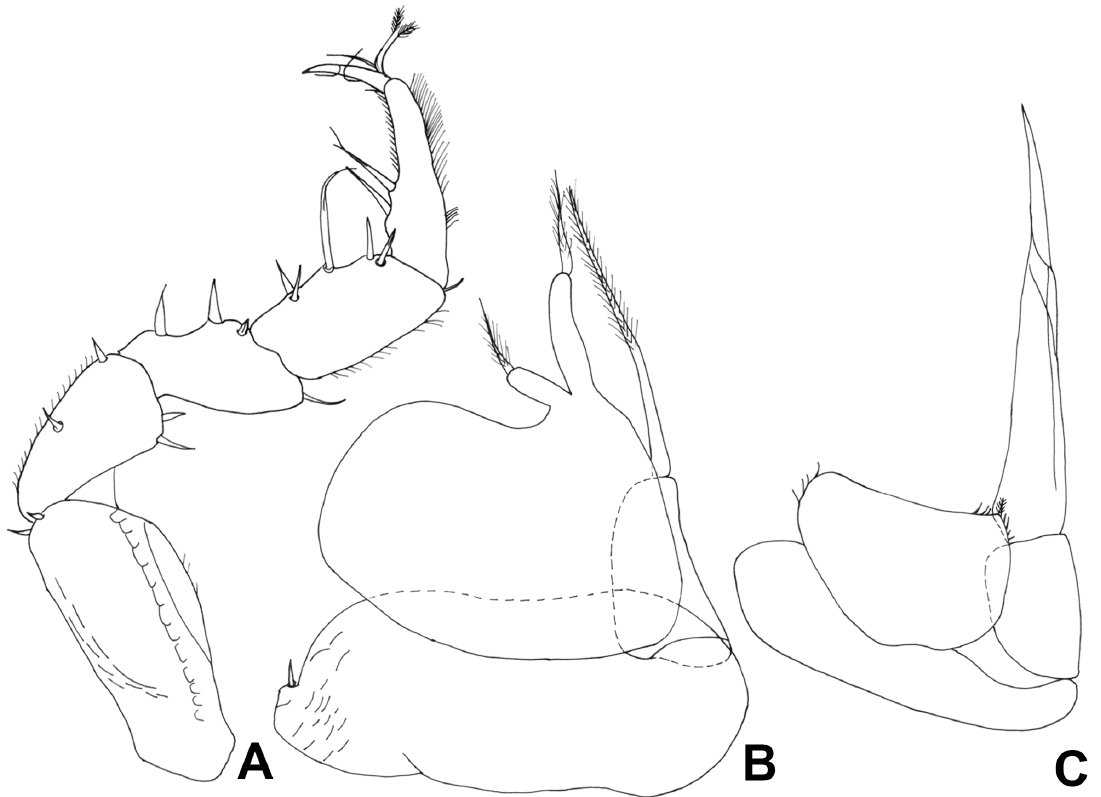
Fig. 3. Trichoniscoides meridionalis Vandel, 1946 from Gruta dos Moinhos, Velhos, Estremenho, ♂. A . Pereopod 7. B . Pleopod 1. C . Pleopod